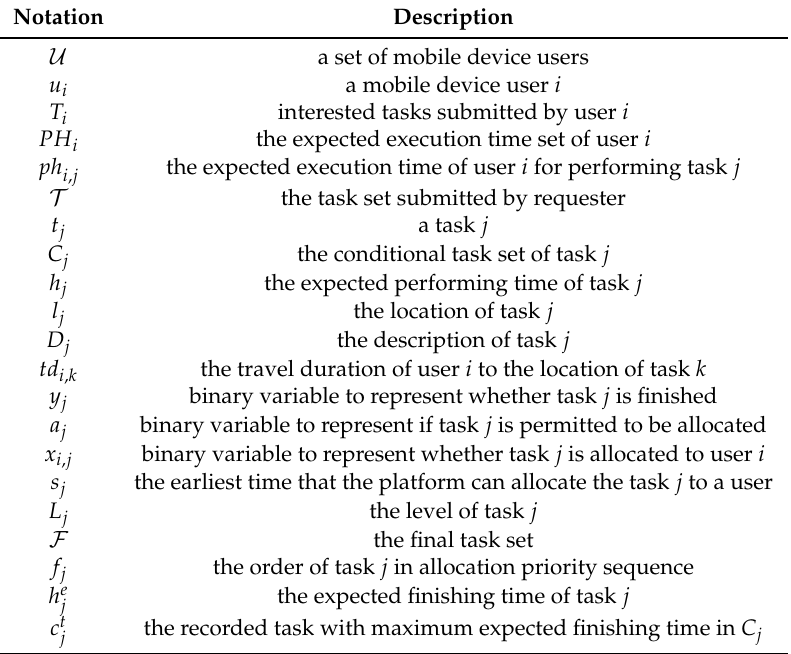
Table 1. The descriptions of notations used in this